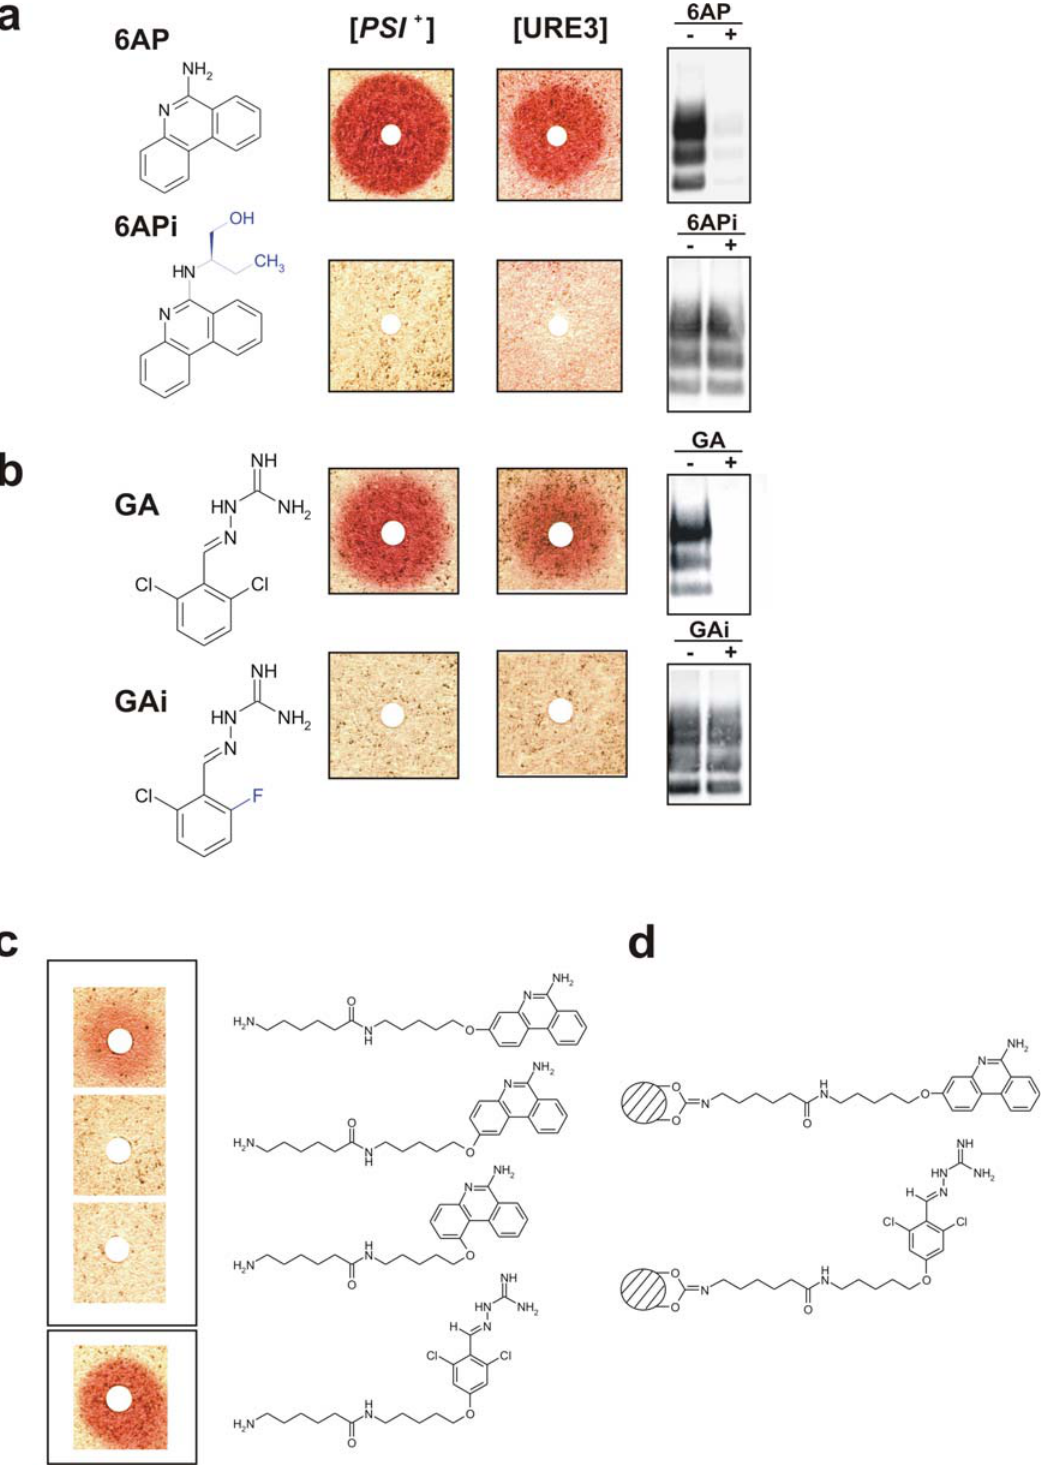
Figure 1. Absence of antiprion activity of 6APi and GAi, two close derivatives of antiprion drugs 6AP and GA and synthesis of affinity matrices for both drugs. a. Left panels: the molecular structure of 6AP and 6APi are depicted. Simple introduction of a 2-(butan-1-ol) group (represented in blue) on the amino group in position 6 is sufficient to abolish the antiprion activity of 6AP. Middle panels: aliquots of an overnight culture of a [ PSI + ] strain (left panel, STRg6) and of a [URE3] strain (right panel, SB34), both growing as white colonies (because they contain prions: see Materials and Methods ), were spread on YPD medium supplemented with 200 m M GuHCl. Small filters (similar to the ones used for antibiograms) were placed on the agar surface. 10 m l of a 10 mM solution in DMSO of 6AP (top) and 6APi (bottom) were spotted on the filters. The Petri plates were then incubated three days at 25 u C. Red halos were observed around the filters where 6AP was loaded, but not around those where 6APi was spotted indicating that, in contrast to 6AP, 6APi is inactive against yeast prions. Right panels: Scrapie-infected MovS6 cells were treated for